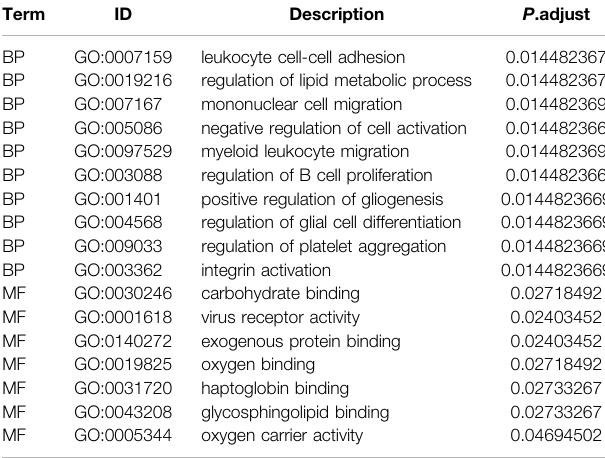
TABLE 2 | Top 10 GO enrichment of IRDEGs.